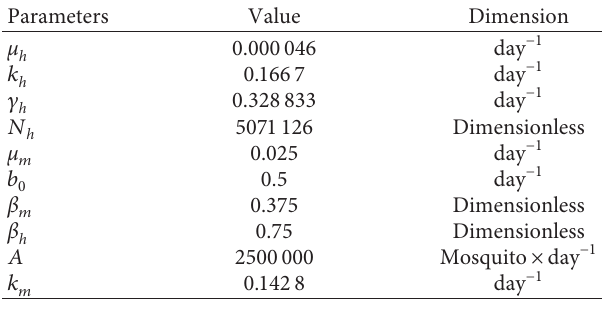
Table 1: Parameters and their values [12].